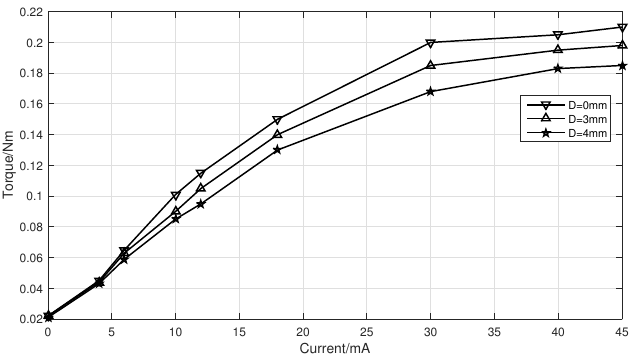
Figure 8. Influence of current input and diameters of limiting holes on torque output.